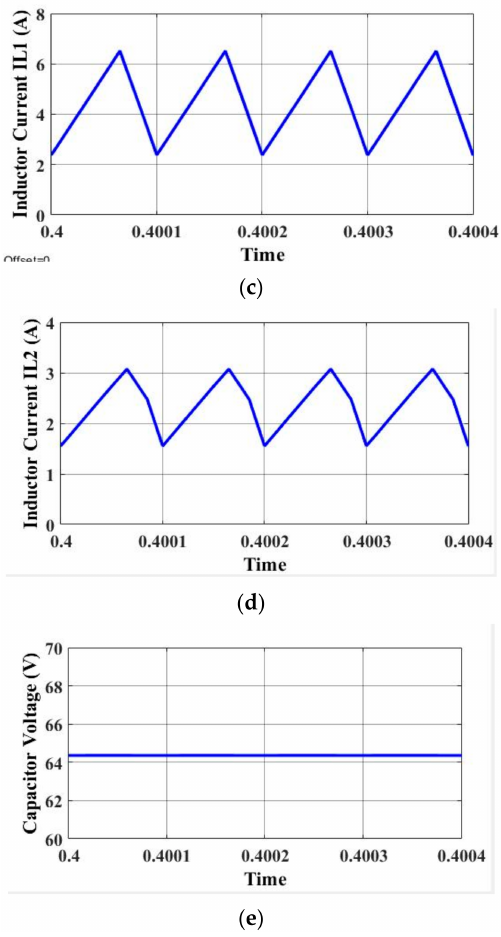
Figure 6. Output wave forms of step-up mode. ( a ) Output voltage, ( b ) output current, ( c ) inductor current (I L1 ), ( d ) inductor current (I L2 ), and ( e ) capacitor voltage (V C1